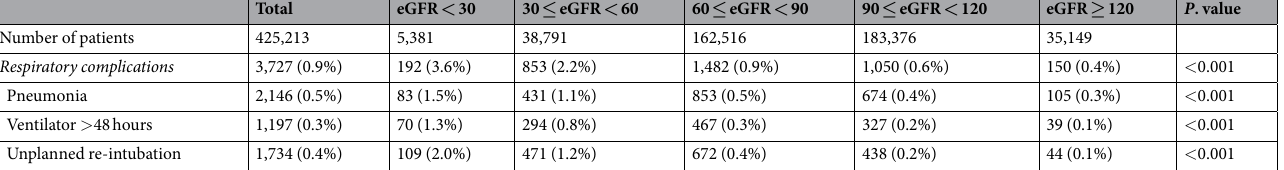
Table 2. Details of pulmonary